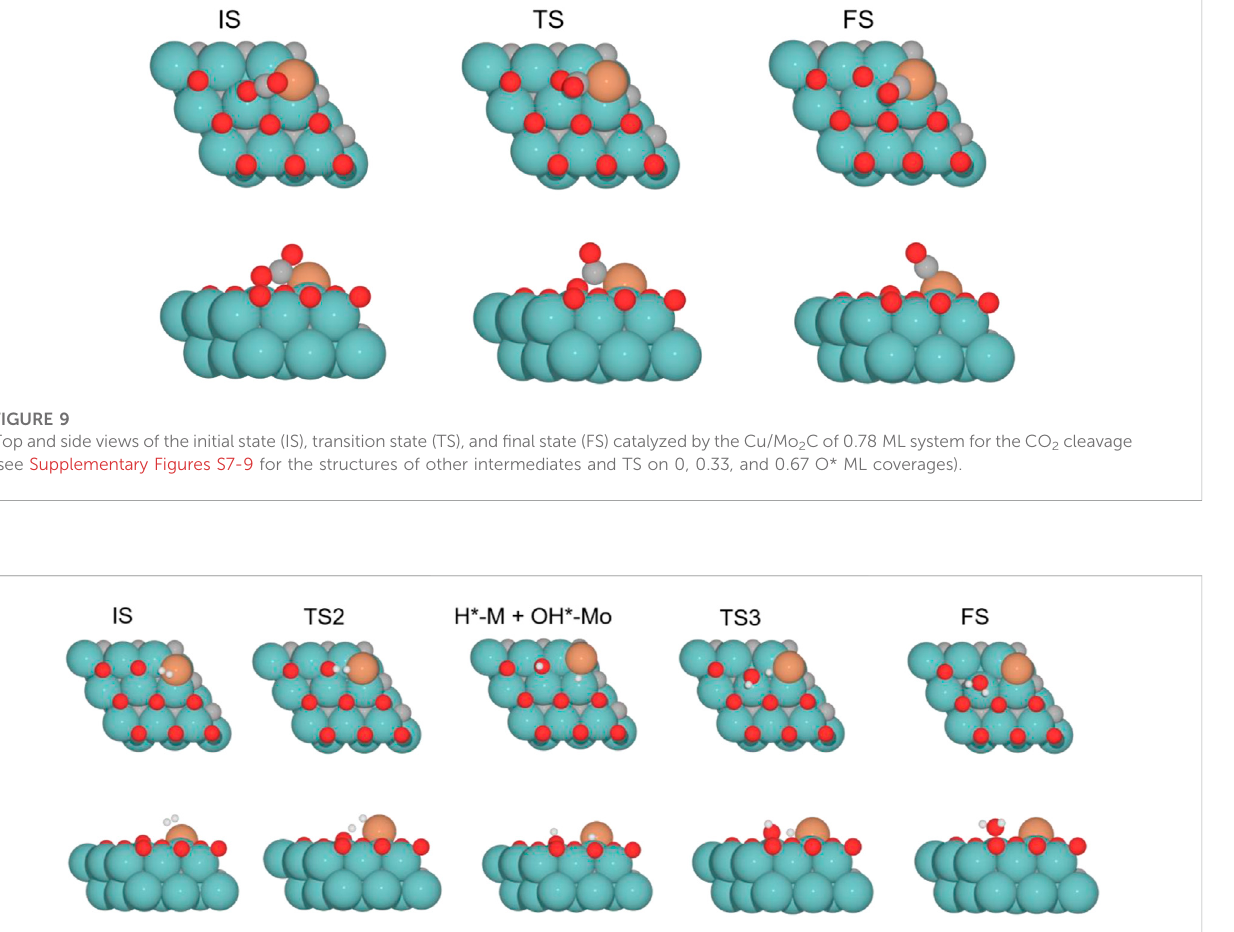
FIGURE 10 Top and side views of structures of the initial state (IS), intermediate, transition state (TS), and fi nal state (FS) on Cu/Mo 2 C of 0.78 O ML coverage for H 2 splitting and the formation of H 2 O (see Supplementary Figures S10-12 for the structures of other intermediates and TS on 0, 0.33, and 0.67 O* ML coverages).